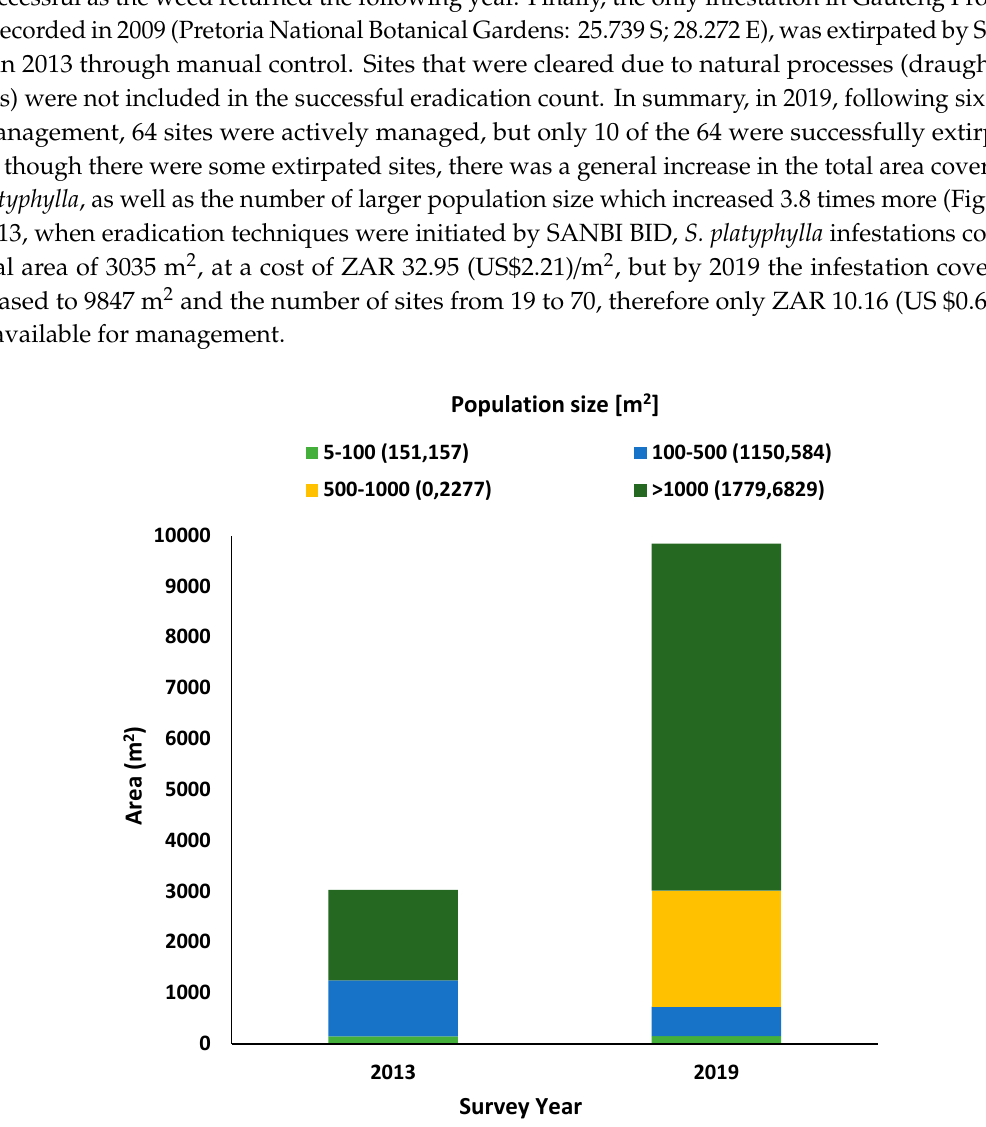
Figure 5. The area occupied by Sagittaria platyphylla infestation composed of different population sizes in South Africa at the initiation of eradication control project in 2013, and after six years of eradication application in 2019. Population size range from small (5–100), medium (100–500), big (500–1000) and large (>1000).